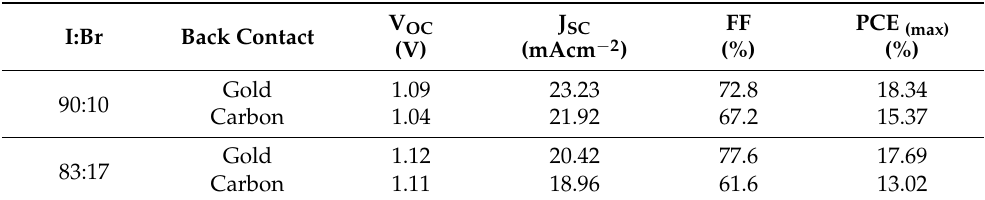
Table 1. The PV parameters of the champion devices with different back contacts (Au and carbon) and halide ratios. PCE (max) stems for the record efficiencies scanned in the backward direction and 20 mV s − 1 scan rate.